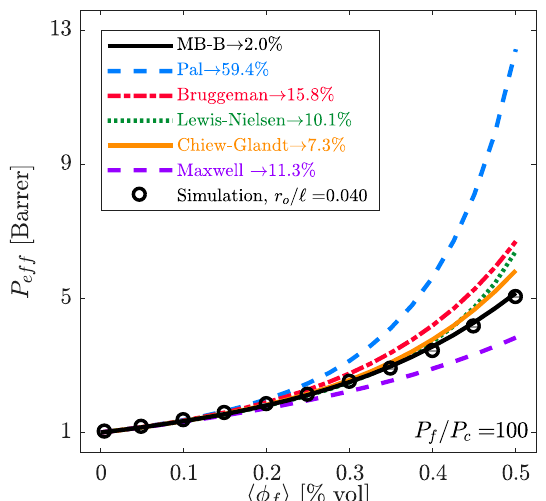
Figure 9. Comparison of the permeability profiles based on various EMA models to simulation results